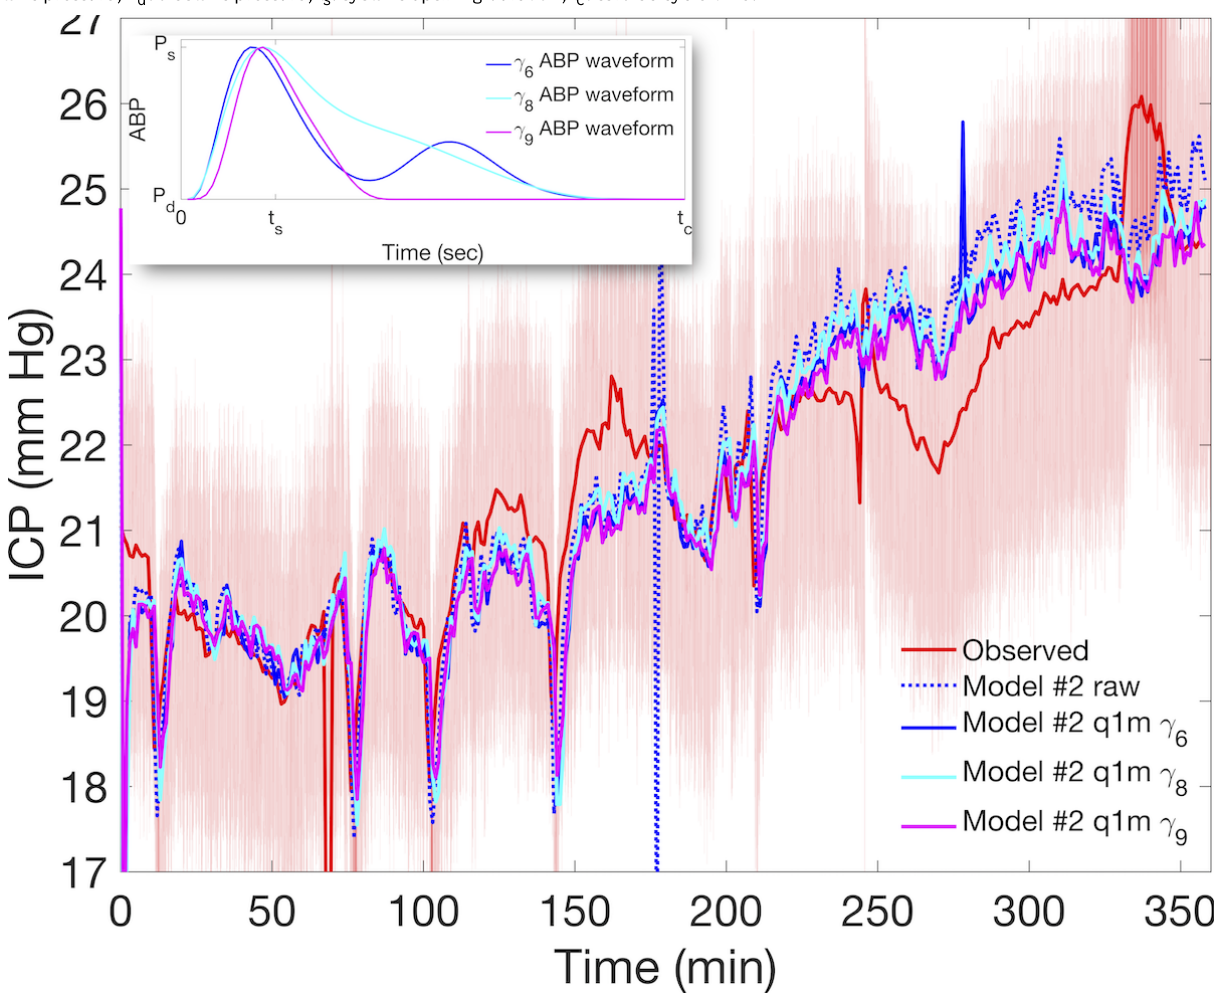
Figure 7. Model #2 performance using quaque 1-min (q1m) summary arterial blood pressure (ABP) data for Charis patient #6. Various simulations using q1m inflow data are compared with observed intracranial pressure (ICP; red curve) and noninvasive intracranial pressure (nICP) estimate based on raw 50 Hz data (dashed blue). Also shown are estimates using minute-wise constant continuous representatives of q1m ABP data generated by correct (blue) and incorrect (magenta and cyan) waveform parameters. The figure inset shows ABP waveform shapes for patients #6 (solid blue), #8 (cyan), and #9 (magenta), respectively, which yield qualitatively indistinguishable nICP estimates in the main plot. This shows that q1m ABP is sufficient for the aortic inflow and that patient-specific parametrization of ABP waveforms has little advantage in the simple model. ICP: intracranial pressure; P s : systolic pressure; P d : diastolic pressure; t s : systolic upswing duration; t c : cardiac cycle